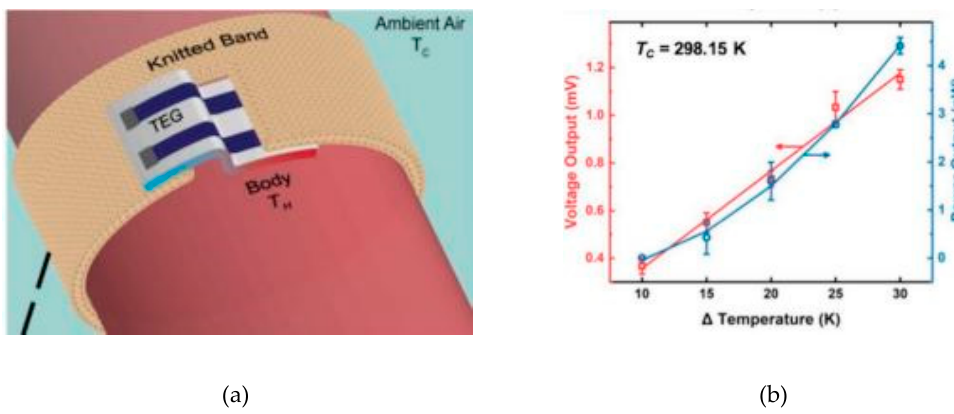
Figure 8. ( a ) Design schematic of a wearable thermoelectric generator; ( b ) thermoelectric power and voltage outputs for a tobacco cotton thermopile at 25 °C. Adapted from [101].